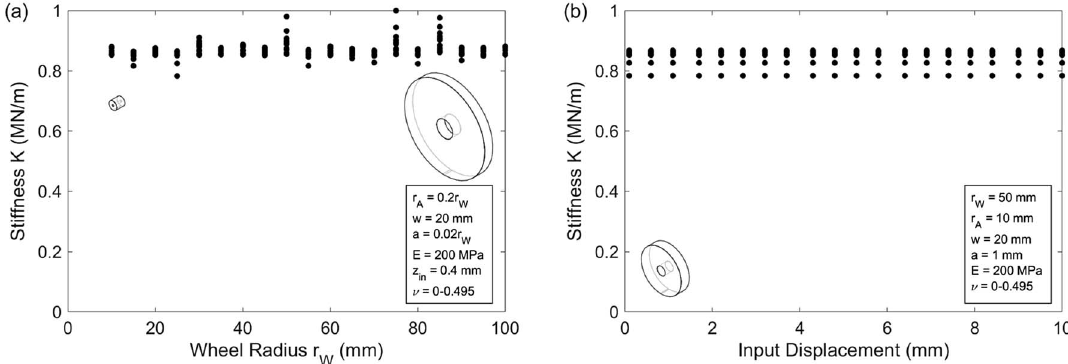
Figure 5. Results of the parametric study: (a) wheel radius r W and (b) input displacement z in . Points having the same x coordinate (but a different y coordinate) are for varying values of Poisson ’ s ratio m . Schematics of the extreme wheel geometries are shown for reference (drawn to scale with respect to one another).